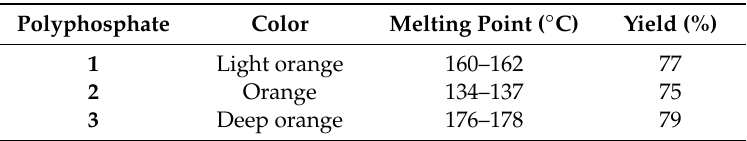
Table 1. Physical properties of 1–3